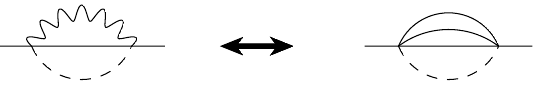
Figure 2 . Left: the dominant \core" diagram contributing to the 2-point function in the supersymmetric FGMS model. Right: the corresponding dominant \core" diagram in the fermionic SYK model. In both graphs the solid lines represent i (cid:12)elds, the wavy lines represent b i (cid:12)elds, and the dashed lines represent a correlation of a product of Gaussian random couplings; C ijk on the left and J ijkl on the right. The full set of dominant graphs is generated iteratively using this core. where repeated indices i; j; k are summed over and C is a totally antisymmetric coupling ijk constant. In component form, this